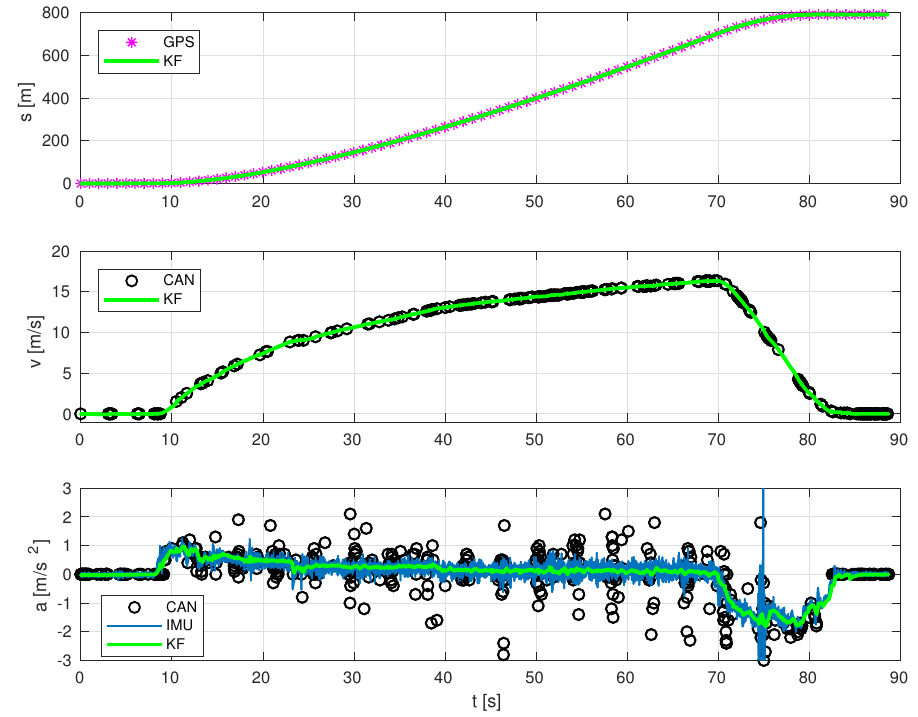
Figure 9. Estimation at a high rate of vehicle’s position, velocity and